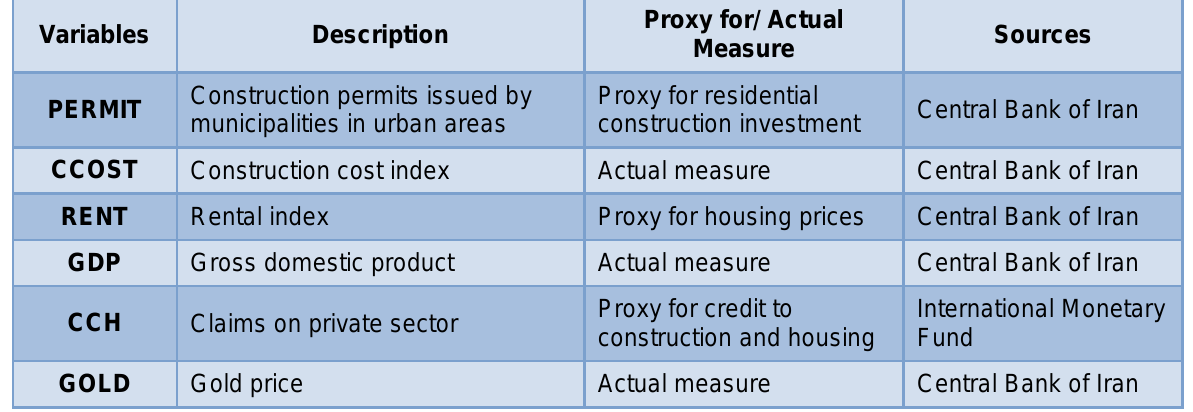
Table 2 Variables, Description and